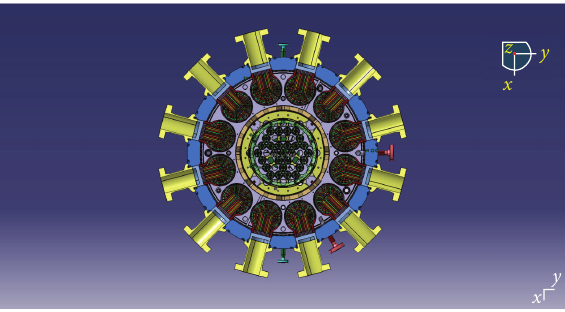
Figure 4: Steam generation lay